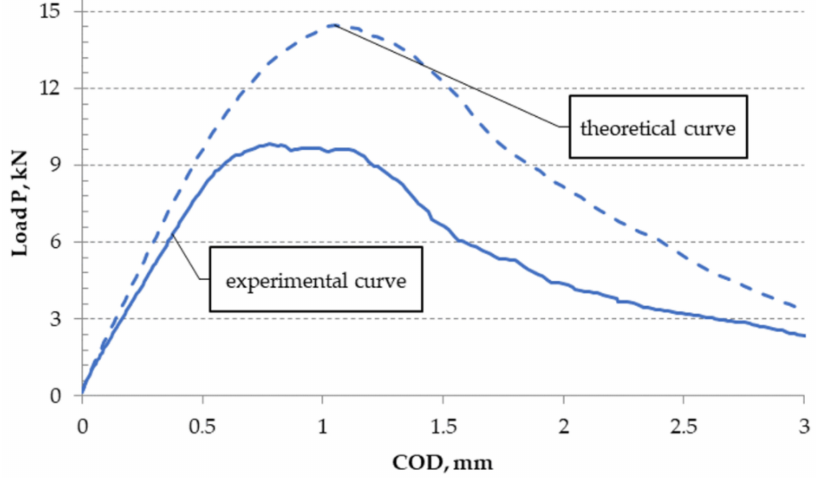
Figure 14. Theoretical and selected experimental diagram curves of the load–crack opening displacement obtained from calculations for a layered Al–Ti material for ambient